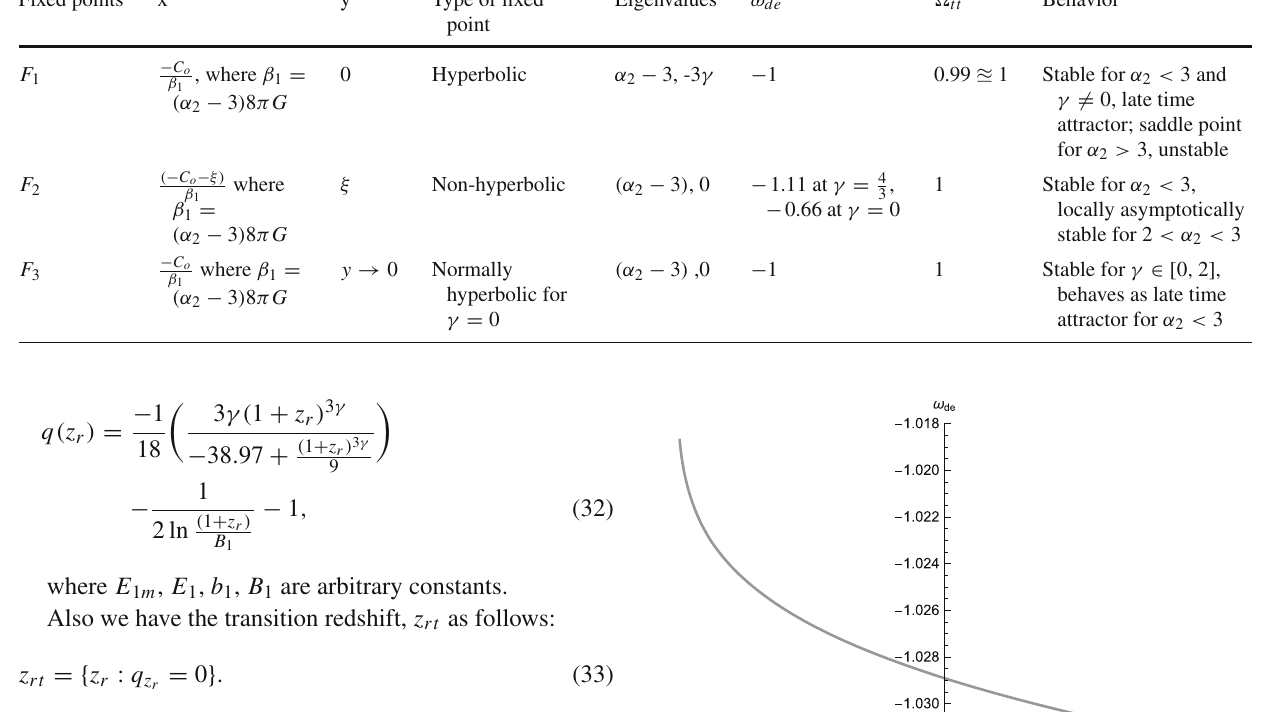
Table 1 Table for Case I ( G =constant, ρ (cid:2) =constant) Fixed points